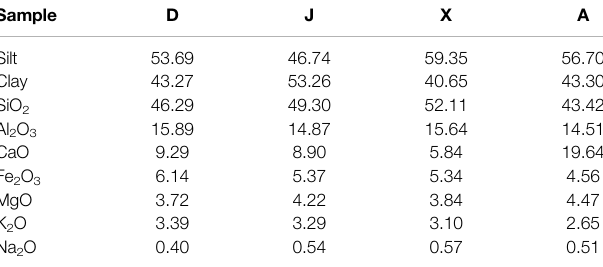
TABLE 2 | Composition of the parent material (%).